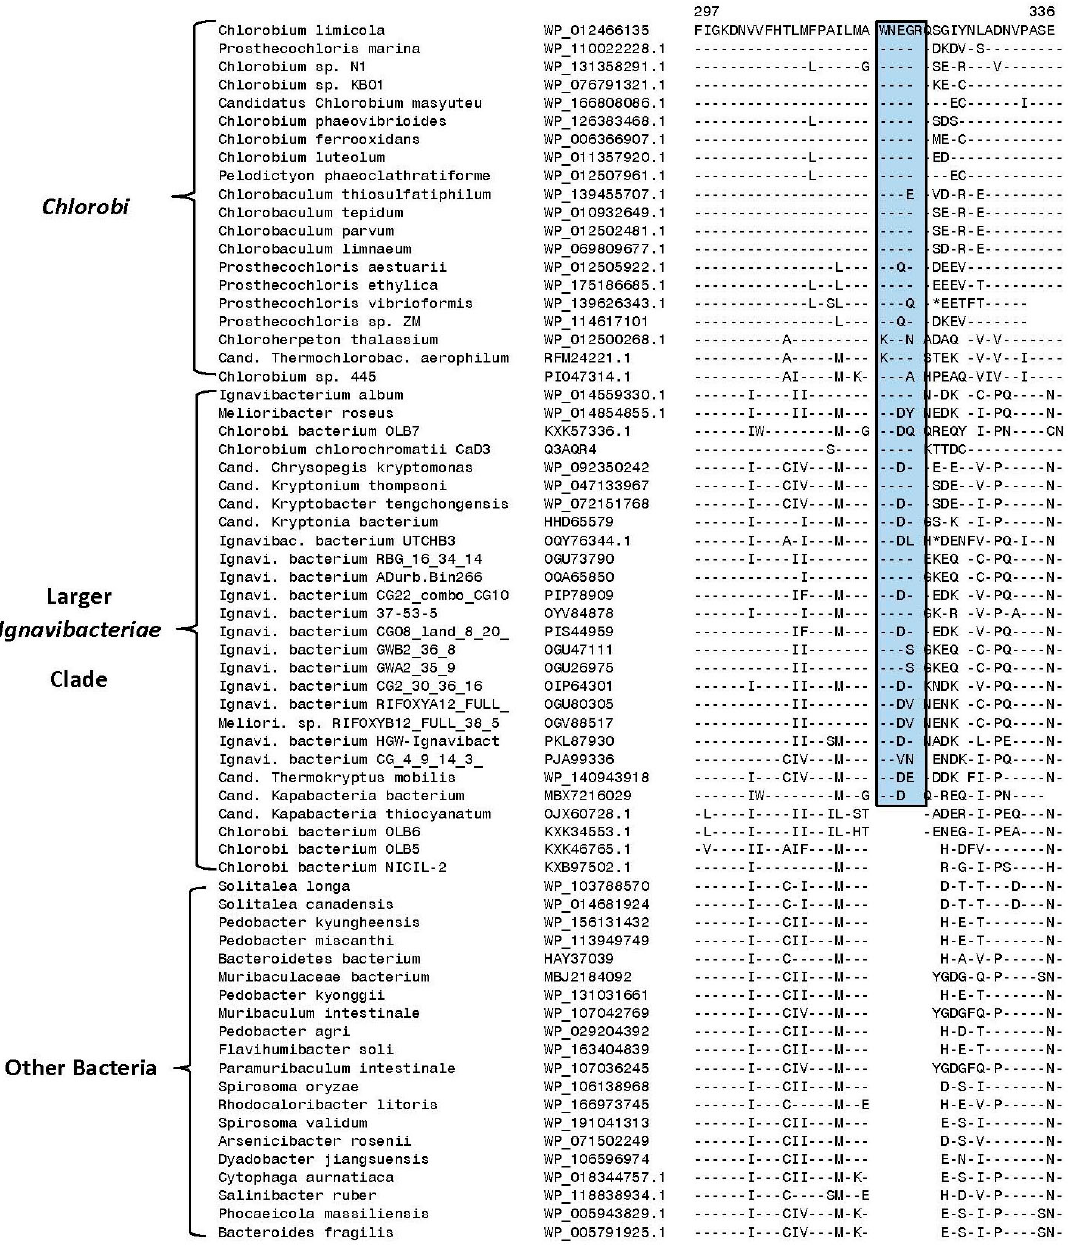
Figure 8. Partial sequence alignment of the protein methionine t-RNA ligase showing a four-amino- acid insertion (boxed) in a conserved region that is specifically shared by all Chlorobia species and most of the species/strains from the larger Ignavibacteria clade (Figure 1). However, this insert is not found in any other outgroup bacteria within the top 500 BLASTp hits. Sequence information for one additional CSI in the protein tRNA-dihydrouridine synthase that is also commonly shared by the species/strains from these two classes is presented in Figure S48.